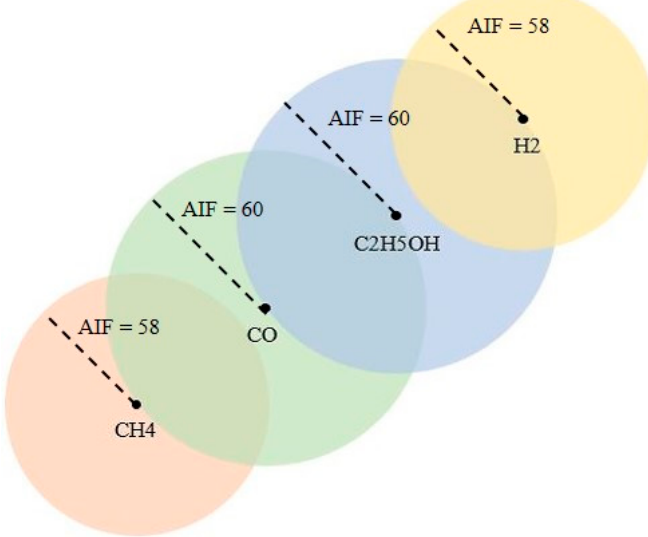
Figure 5. Pictorial representation of LIF neurons, with their respective active influence field (AIF), in the decision space after supervised learning of reference rank-order patterns from [15] dataset .